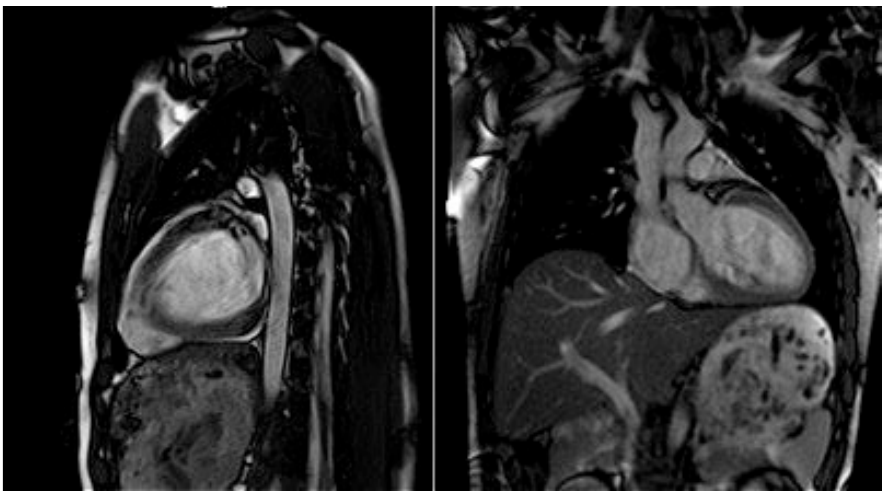
Figure 3. Cardiac magnetic resonance imaging with decreased LV systolic function and dilated